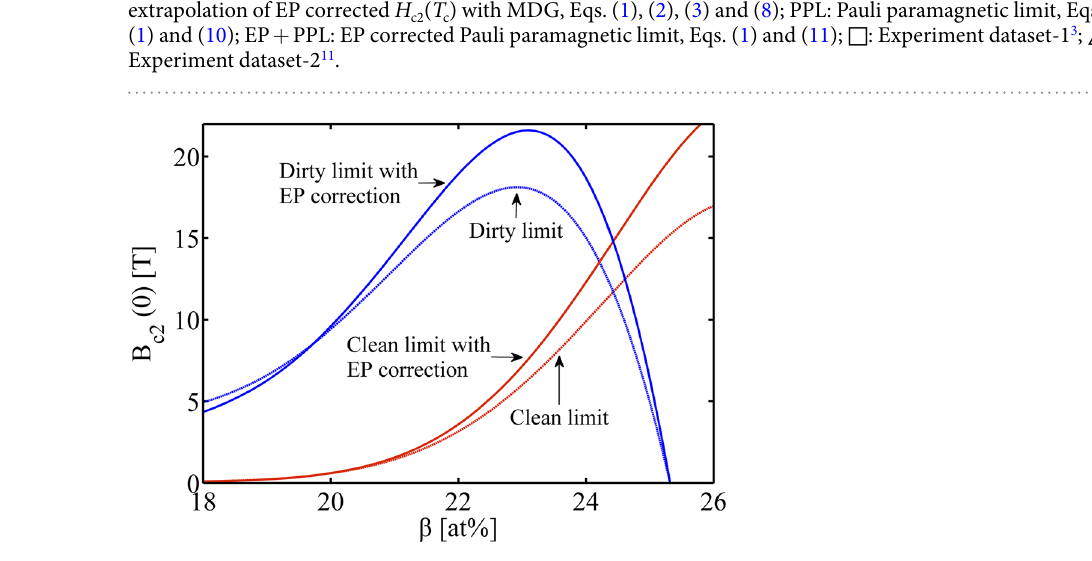
Figure 5. Upper critical field B c2 (0) in the clean and dirty limit